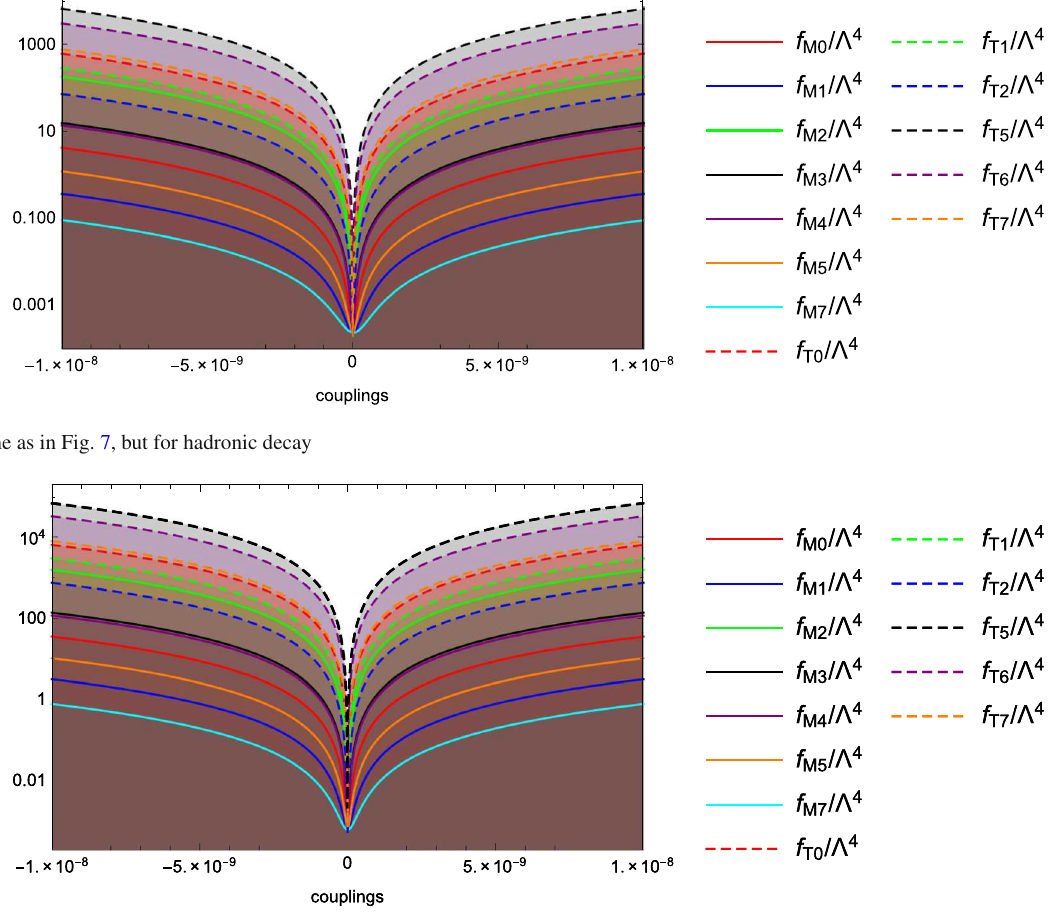
Fig. 10 Same as in Fig. 8, but for hadronic